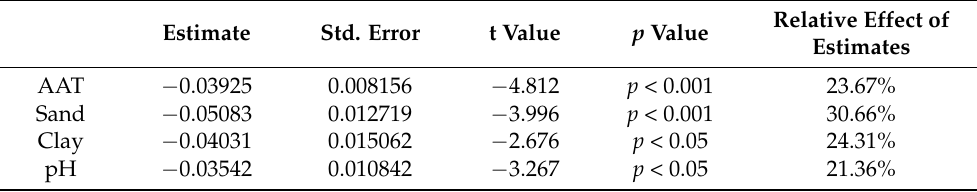
Table 2. Effect of environmental variable distance on NDEP. See Table S3 for model